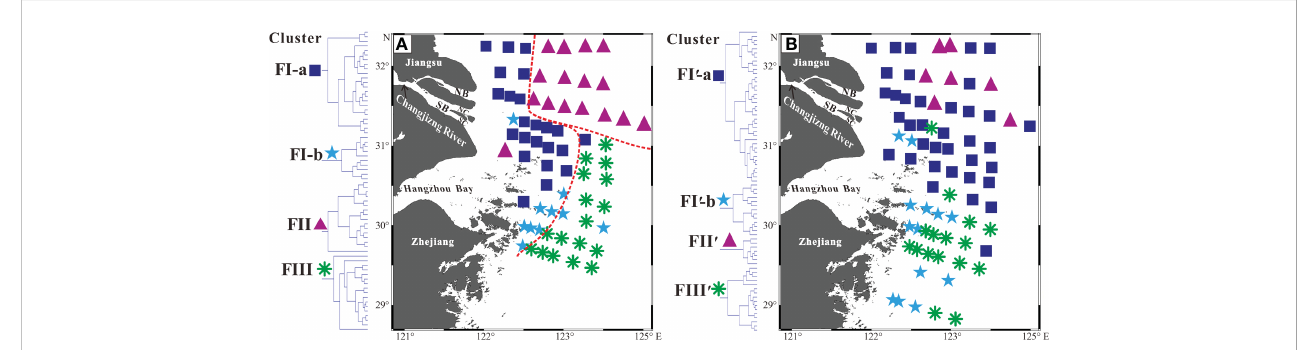
FIGURE 5 Partition maps of living (A) and dead (B) benthic foraminiferal assemblages. Blue squares, cyan stars, purple deltas, and green asterisks denote Clusters FI-a, FI-b, FII, and FIII in (A) , and FI ′ -a, FI ′ -b, FII ′ , and FIII ′ in (B) . See Figure 4 for the information of different clusters and their associated